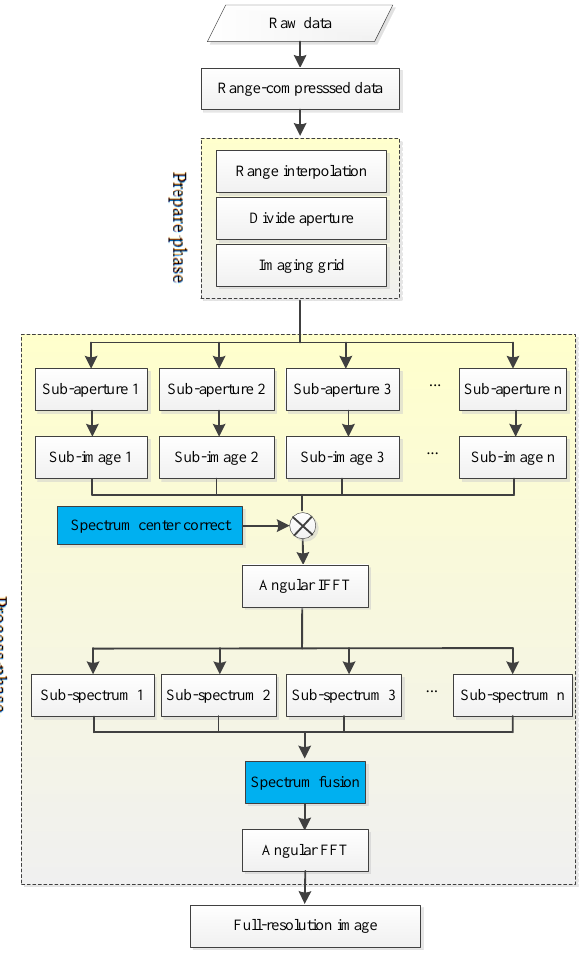
Figure 4. Flowchart of HSHD-AFBP.